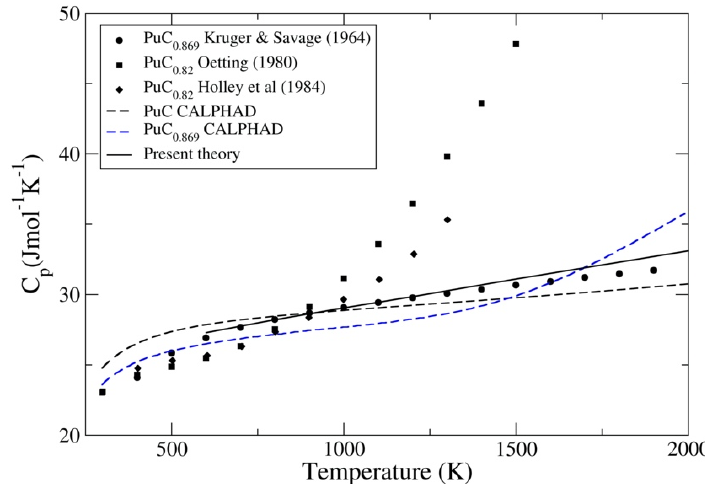
Figure 10. Specific heat at constant pressure, C p , for PuC. Present theory is here indicated by the solid line. Experimental data are from [75–77] and CALPHAD data are shown with a dashed line, corresponding to stoichiometric PuC and sub-stoichiometric PuC 0.869 .